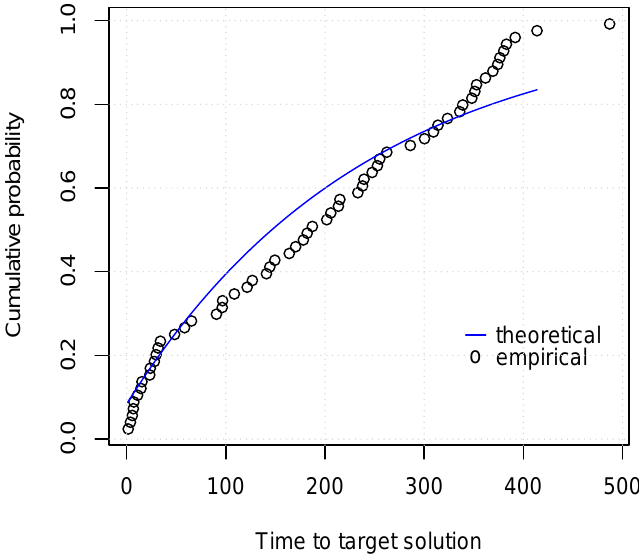
Figure 4. Time-to-target plot for an instance with 800 trips based on 75 independent runs of the GRASP